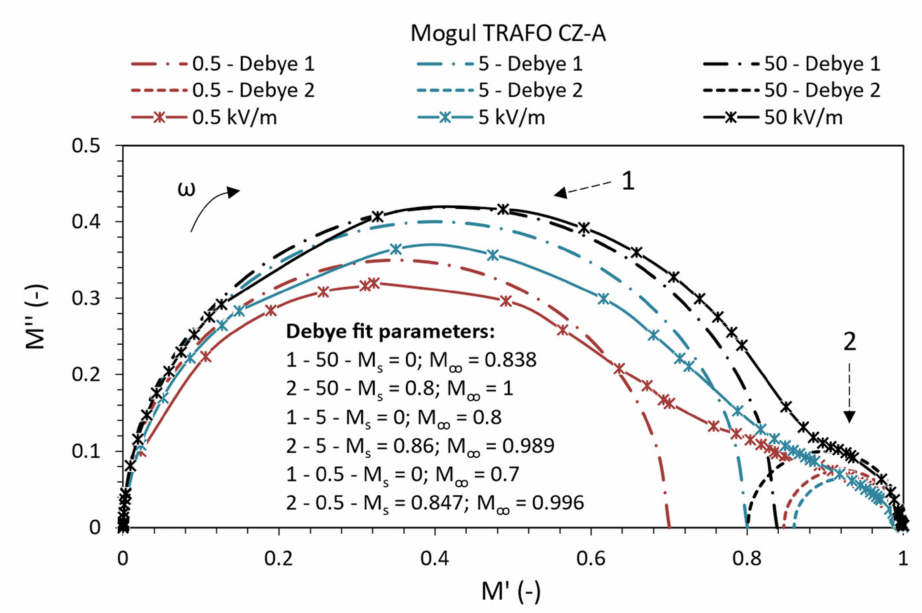
Figure 4. Cole-Cole diagram of a complex electric modulus M* of MO